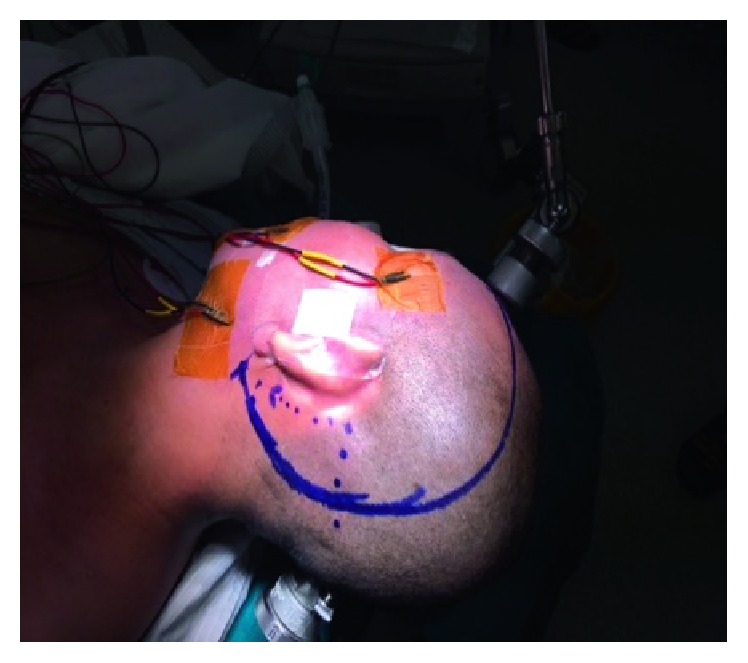
C-shaped incision.